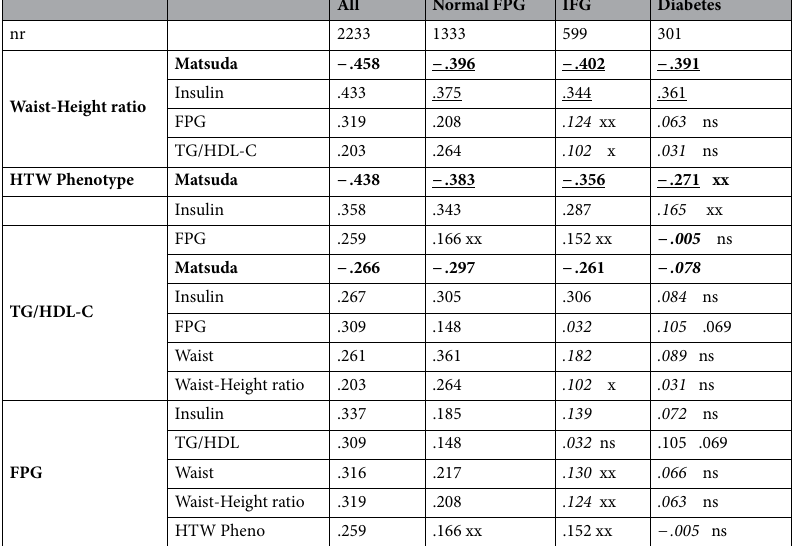
Table 4. Correlation coefficients for the potential markers of dysmetabolic phenotype ( p values are < 0.001 unless indicated otherwise). xx = p < 0.01, ns = no significance. Underlined numbers indicate relevant and similar associations in the three subgroups. Italicized numbers demonstrate a weak or lost correlation in one of the subgroups compared to NFG. Bold letters indicate the central correlations of a specific phenotype marker with the Matsuda index for comparison between these markers.